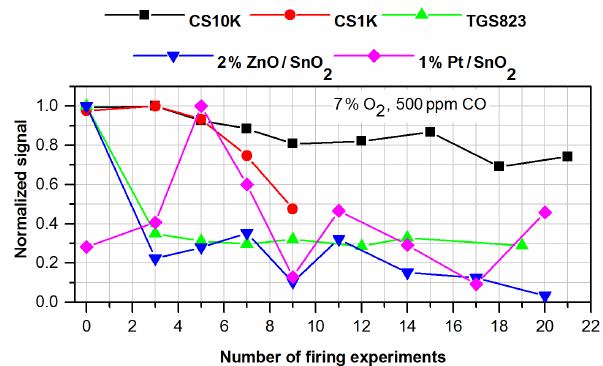
Figure 8. A comparison of the normalized sensor signals of the different sensors upon exposure to 500ppm of CO at a 7% oxygen concentration plotted vs. the number of firing experiments. The av- erage gas exposure time of the sensors per firing experiment was about